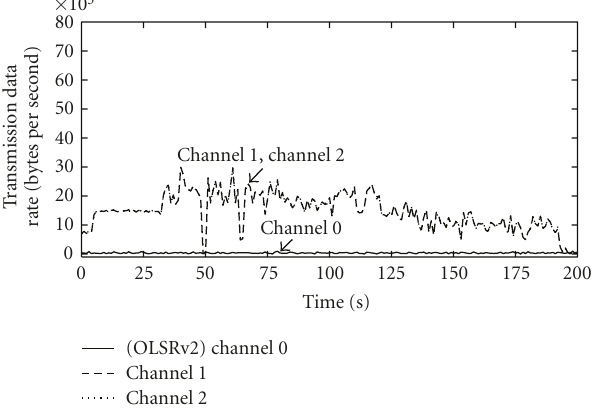
Figure 17: Transmission data rate per channel at node A.